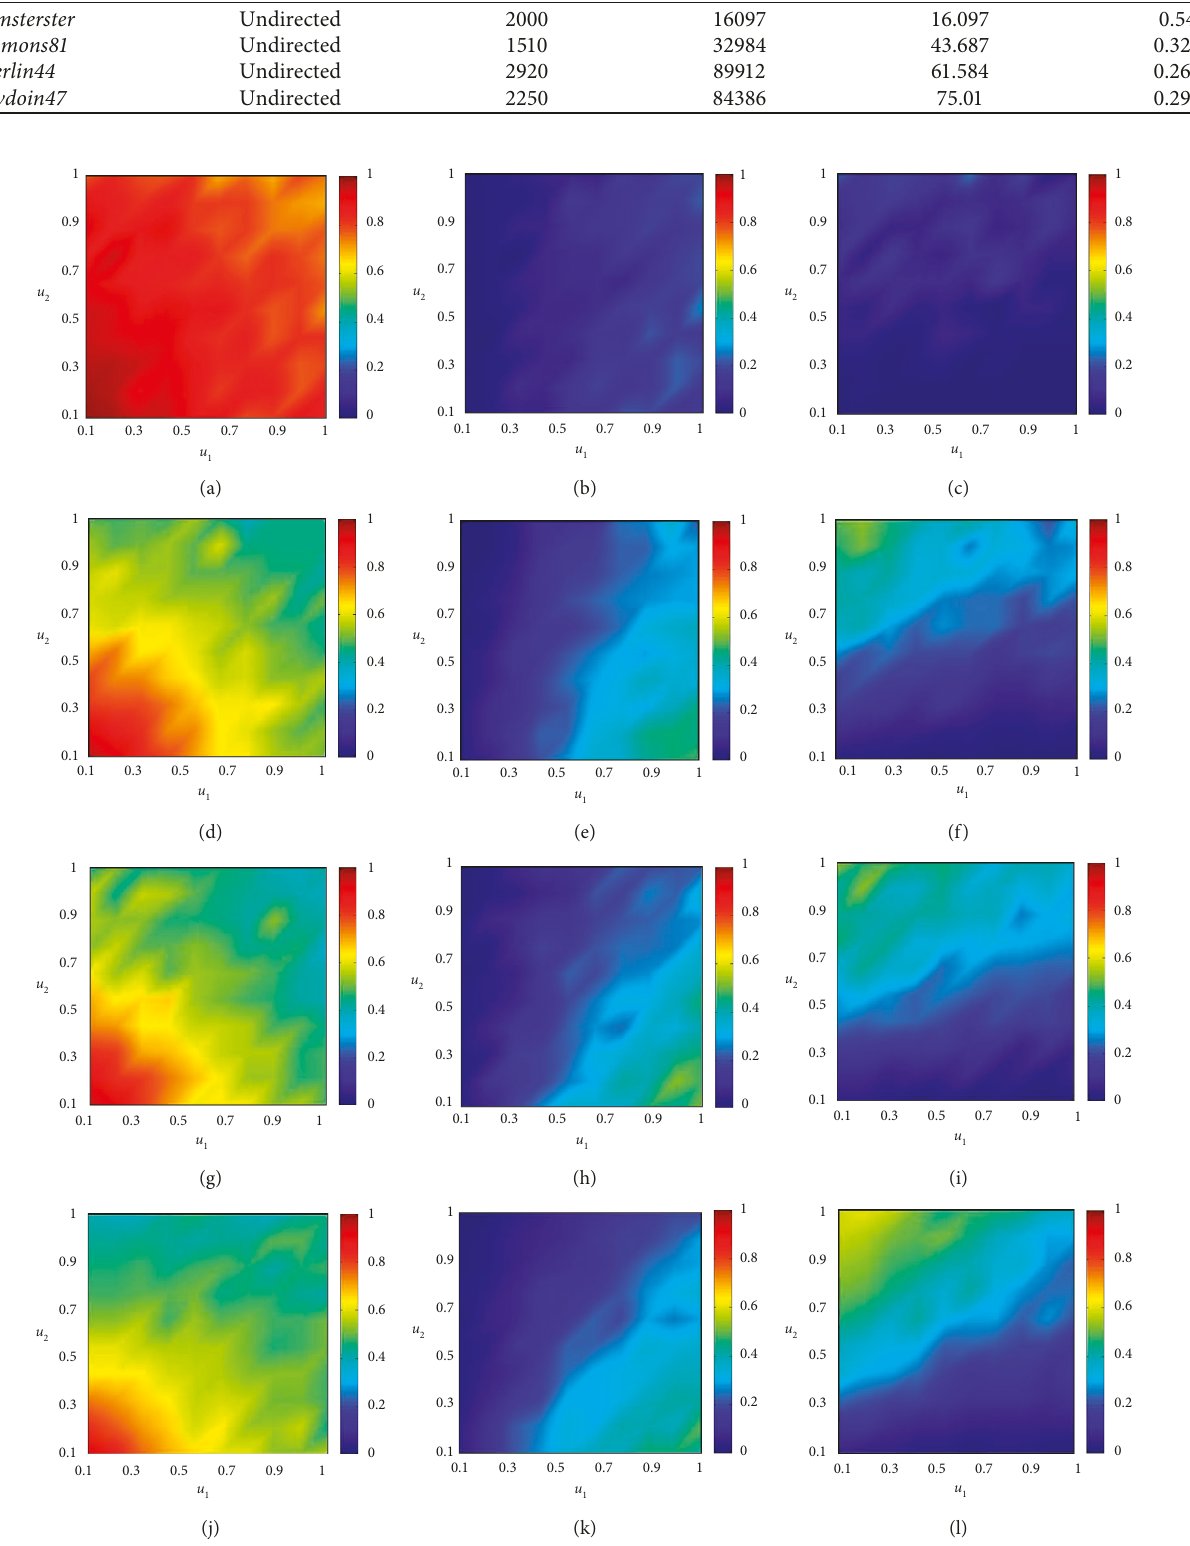
u and u payoffs in the four networks. Parameters are set as α 1 � 2, α 2 � 2, q u � 0.1, and I , ρ B 1 , and ρ B 2 for different 1 2 of Hamsterster ; (c) ρ B of Hamsterster ; (d) ρ I of Simmons81 ; (e) ρ B 1 2 of Oberlin44 ; (i) ρ B of Oberlin44 ; (j) ρ I of Bowdoin47 ; (k) ρ B 1 2